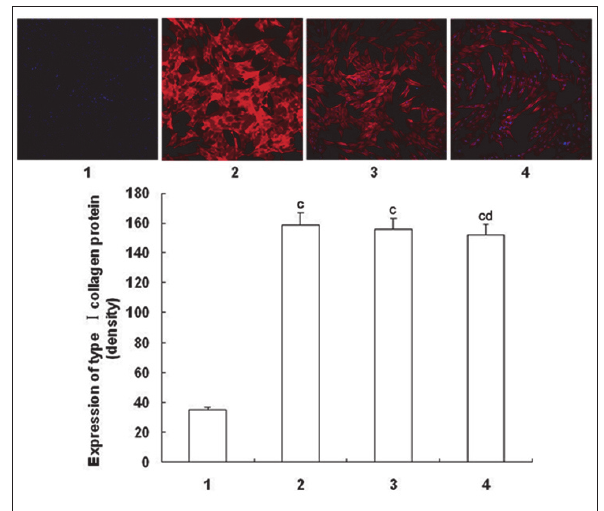
Fig. 3. Immunofluorescence staining for type I collagen in cultured HUMSCs. Anti-type I collagen polyclonal antibody stained cytoplasm showed red fluorescence in non-diabetic group and diabetic group, and no cytoplasmic staining was seen in negative control group. Counterstaining of the cell nu- clei was performed with Hoechst 33342 (magnification 20 ×). 1: Negative control group; 2: Positive control group; 3: Non- diabetic group; 4: Diabetic group